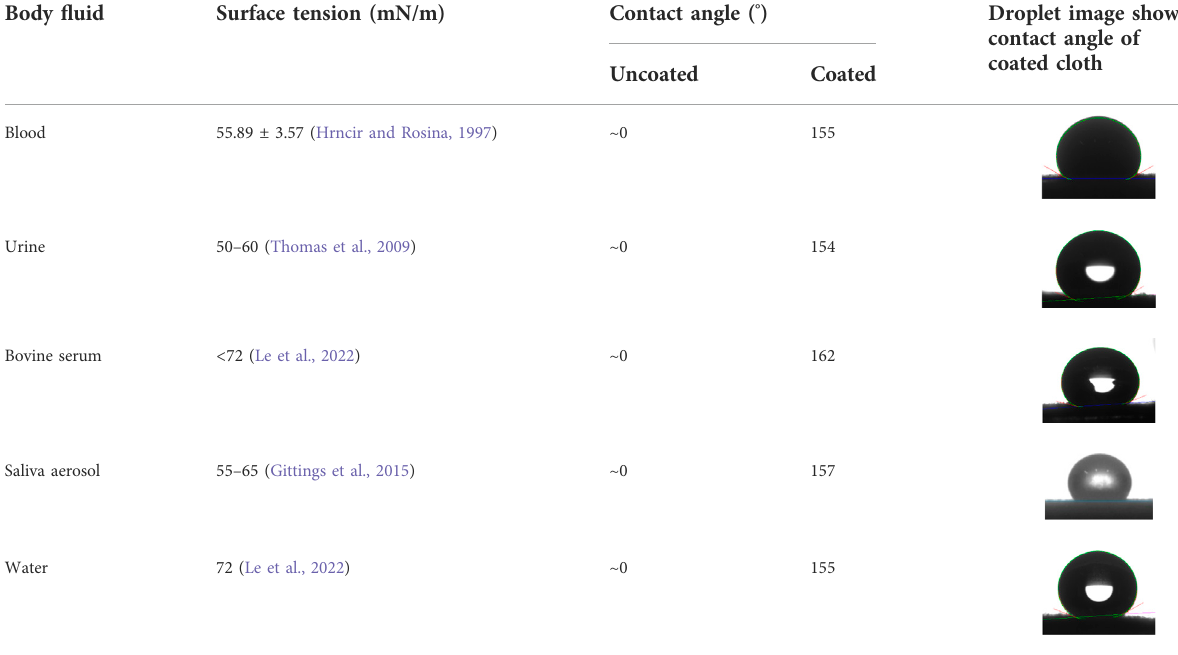
TABLE 1 The contact angle of body fl uid for uncoated and coated cloth surfaces and their images. Body fl